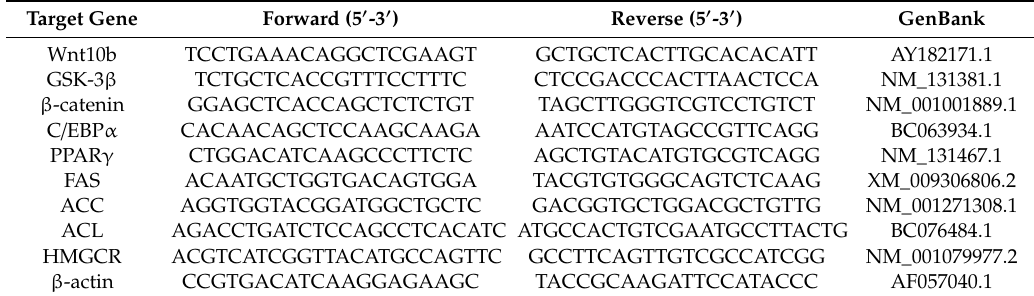
Table 2. Real-time quantitative Polymerase Chain Reaction primers for genes of